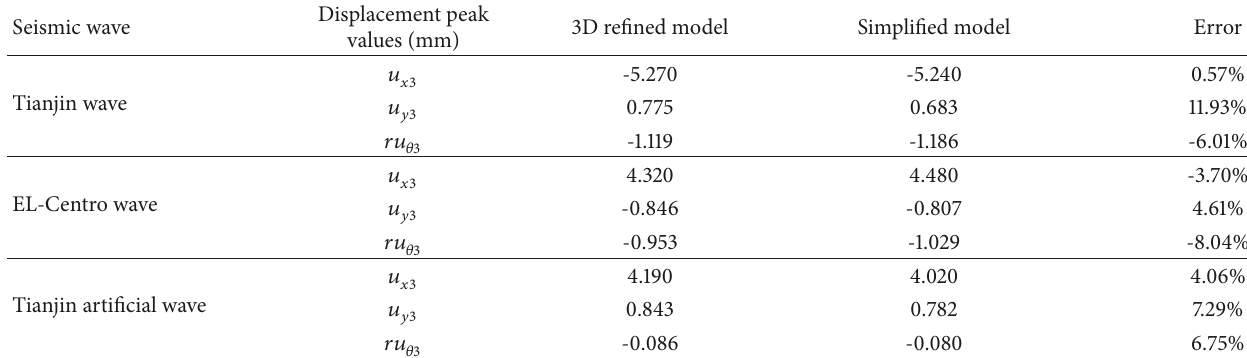
Table 1: The peak values of the top floor displacement under frequently occurred earthquake.